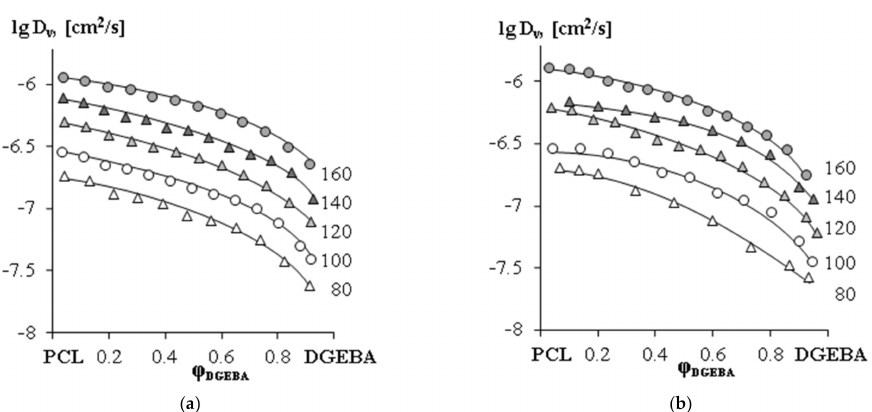
Figure 12. The concentration dependences of interdiffusion coefficients for ( a ) PCL (M n = 45 × 10 3 ) –DGEBA system; ( b ) PCL (M n = 80 × 10 3 ) — DGEBA system. The temperatures ( ◦ C) are indicated near the curves.